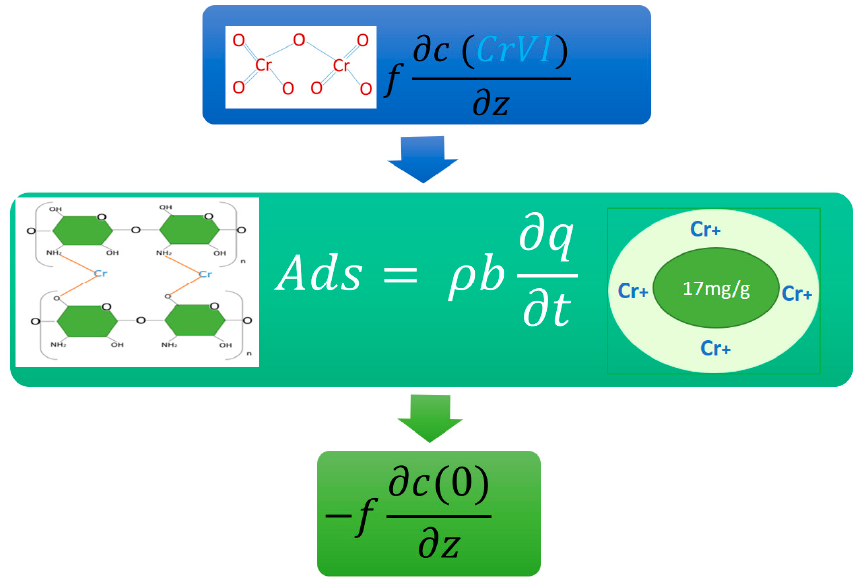
Figure 1. Representation of the filter model in the Cr (VI) treatment process—mathematical model of input, output and internal adsorption.